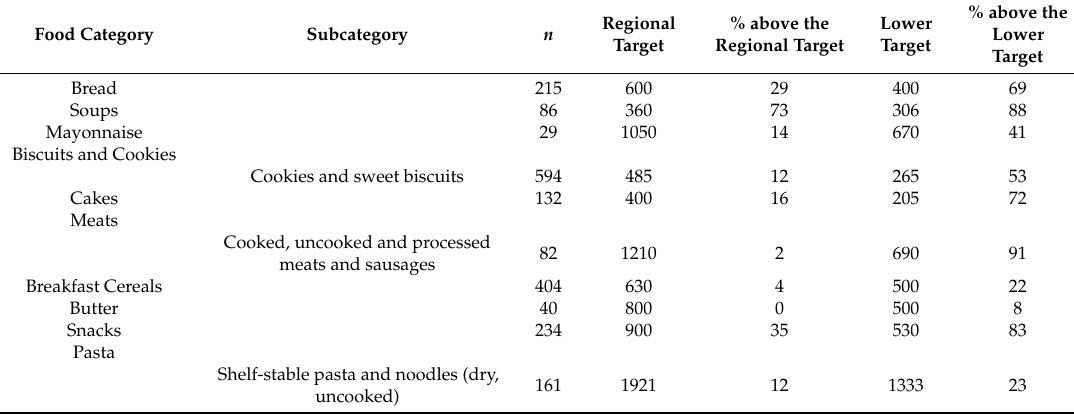
Table 3. Percentage of 1977 processed foods that exceed the regional and lower sodium reduction targets set by the Pan American Health Organization